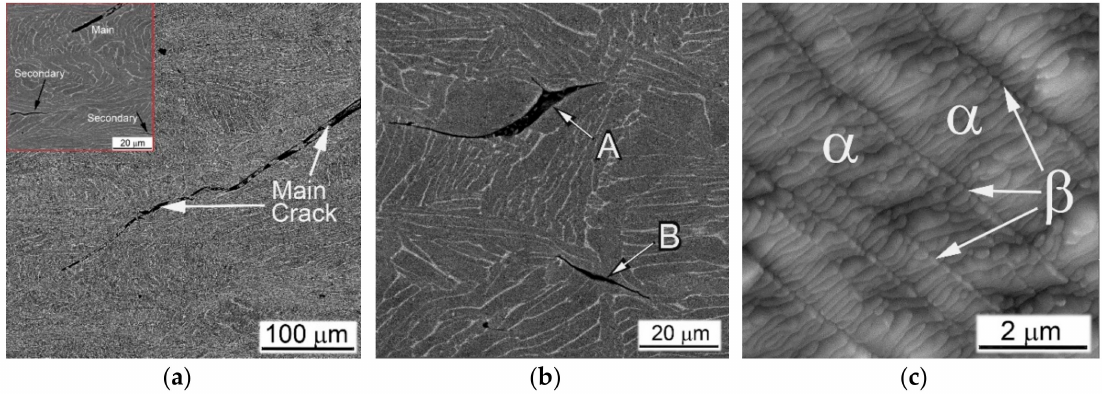
Figure 19. The SEM images of the fractured Ti64BEPM specimen after the quasi-static tests at the strain rate of 0.001 s − 1 : ( a ) main crack—zone II; ( b ) collapsed residual pores—zone II; ( c ) cellular dislocation substructure inside the curved lamellae of the α -phases—zone IV. ( a , b ) BSE, ( c )